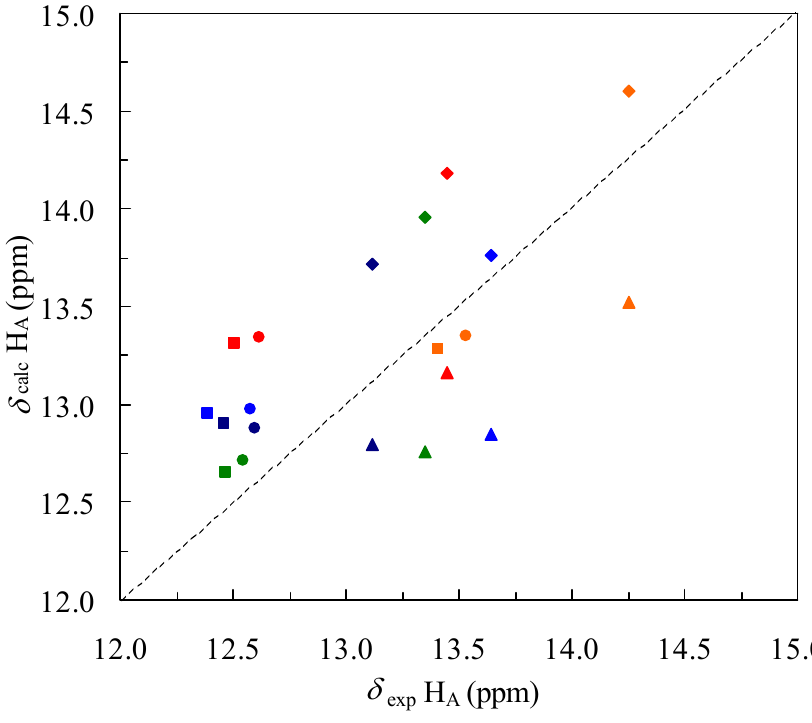
Fig. 7 Plot of calculated 1 H-NMR chemical shifts vs. experimentally observed 1 H-NMR chemical shifts of the H A proton. The TSC, MTSC, Z -DMTSC, and E -DMTSC results are presented as squares, circles, diamonds, and triangles, respectively; the results for ANQ, I, MI, IS, and ALL series are in red, dark blue, blue, green, and orange,